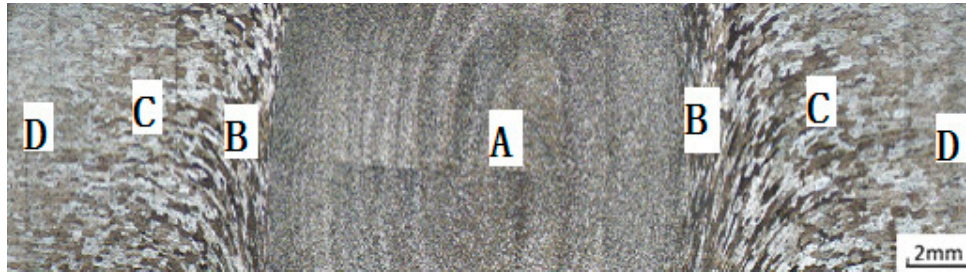
Figure 2. Metallograph of the aluminum alloy FSW joints: ( a ) WNZ, ( b ) TMAZ, ( c ) HAZ, ( d ) BM.